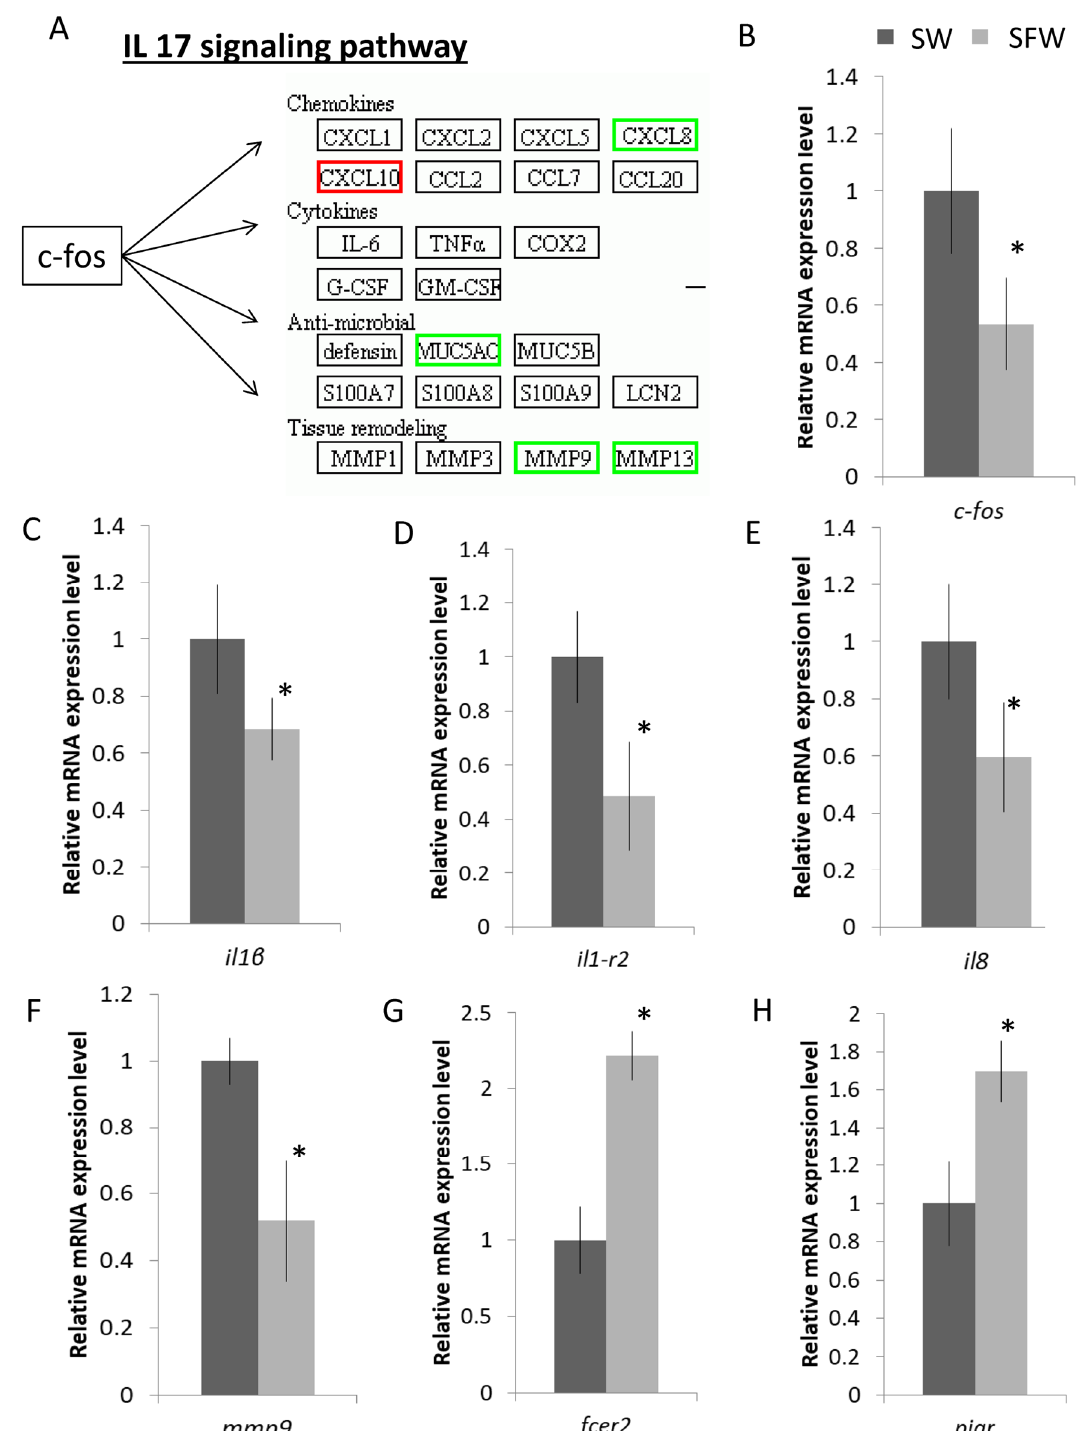
Figure 5. Hypo-osmotic stress influences the immune system in gill cells. ( A ) IL-17 signaling pathway was enriched in the SW/SFW group; green indicated the reduced transcripts, while red indicated the up-regulated transcript. The transcription factor, c-fos, could induce various down-stream targets. ( B – H ) Validations of the mRNA gene expression levels of the selected transcripts by real time qPCR. Down-regulation of the selected immune-related genes (transcription factor c-fos ; interleukin-related genes ( il1-r2 ; il1b ; and il8 ); tissue remodelling gene , mmp9 ) and up-regulation of the selected immunoglobulin-related receptors ( fcer2; and pigr ) after the transfer. Results matched with the sequencing data. n = 5; mean ± s.e., * indicated p < 0.05.